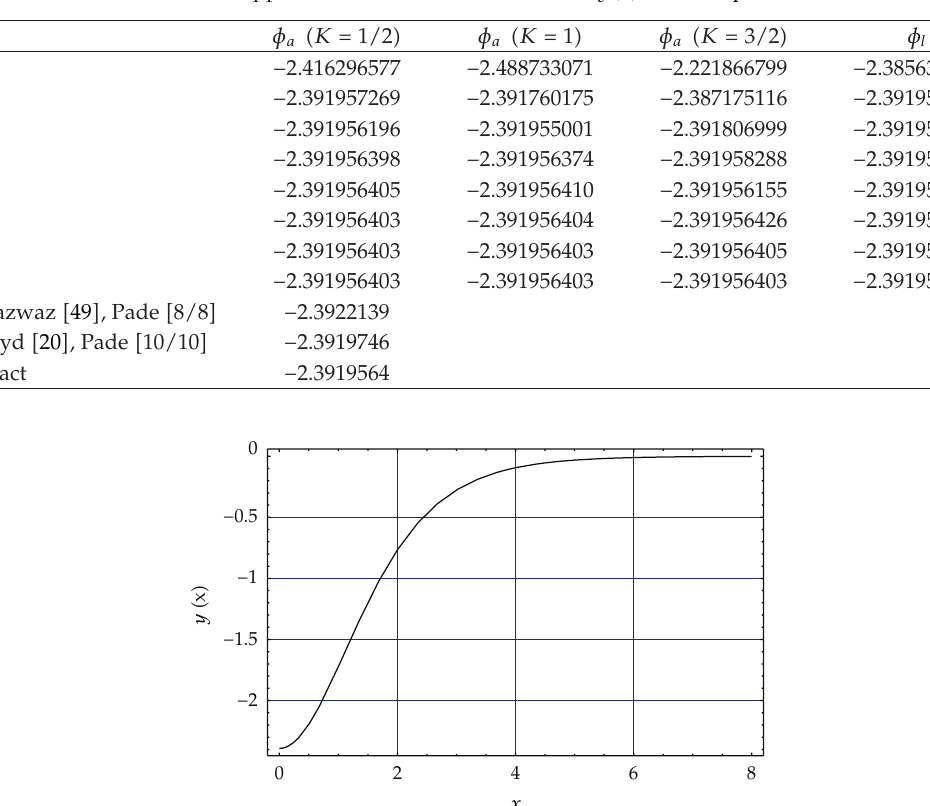
Table 7: Approximate and exact values of α (cid:9) y (cid:4) 0 (cid:3) for Example 4.5.